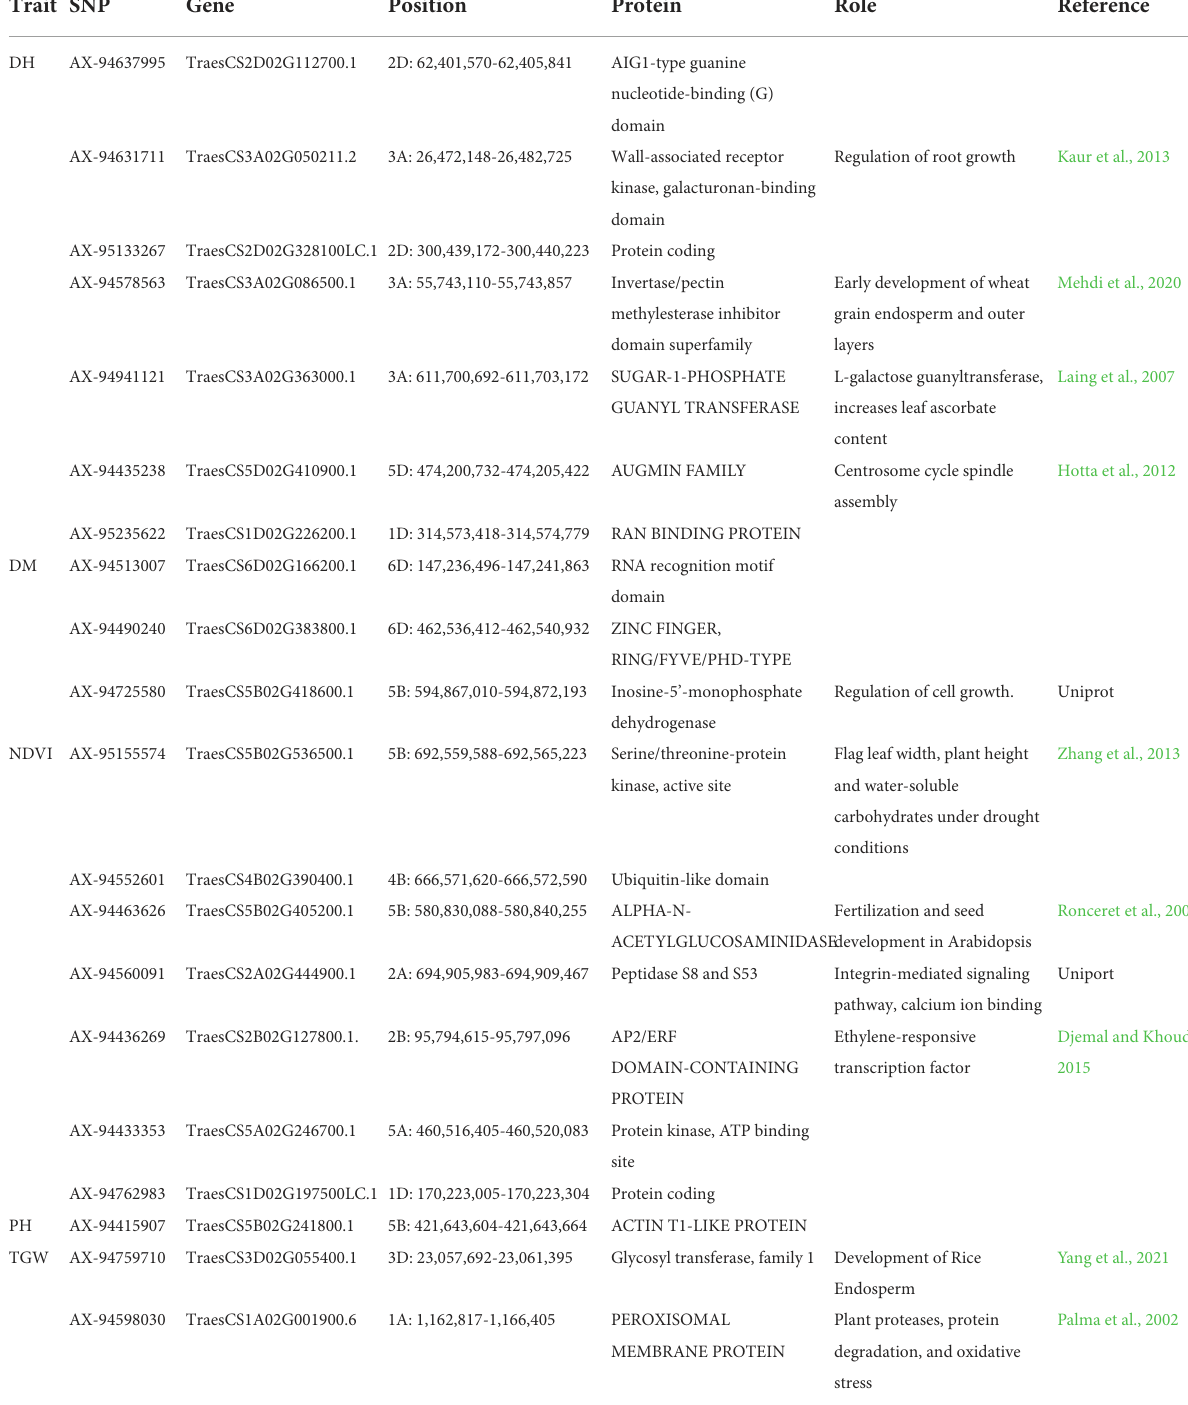
TABLE 6 Putative candidate genes identified at the 10kb region of Linked SNPs along with their molecular functions. Trait SNP Gene